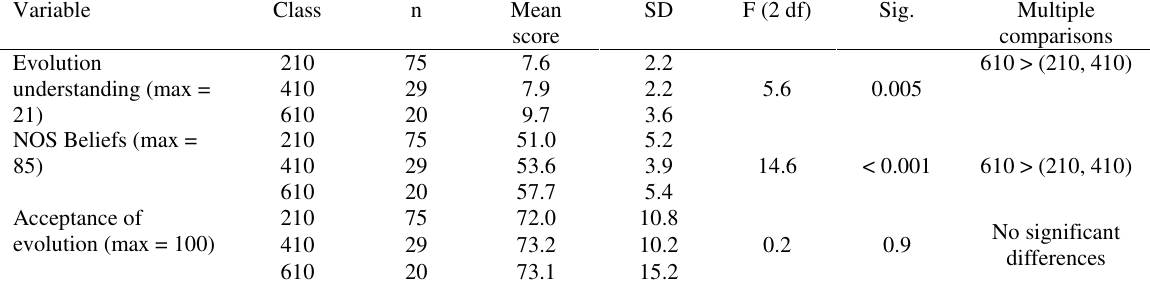
Table 2 Summary statistics and results of ANOVA comparison of group means for each variable